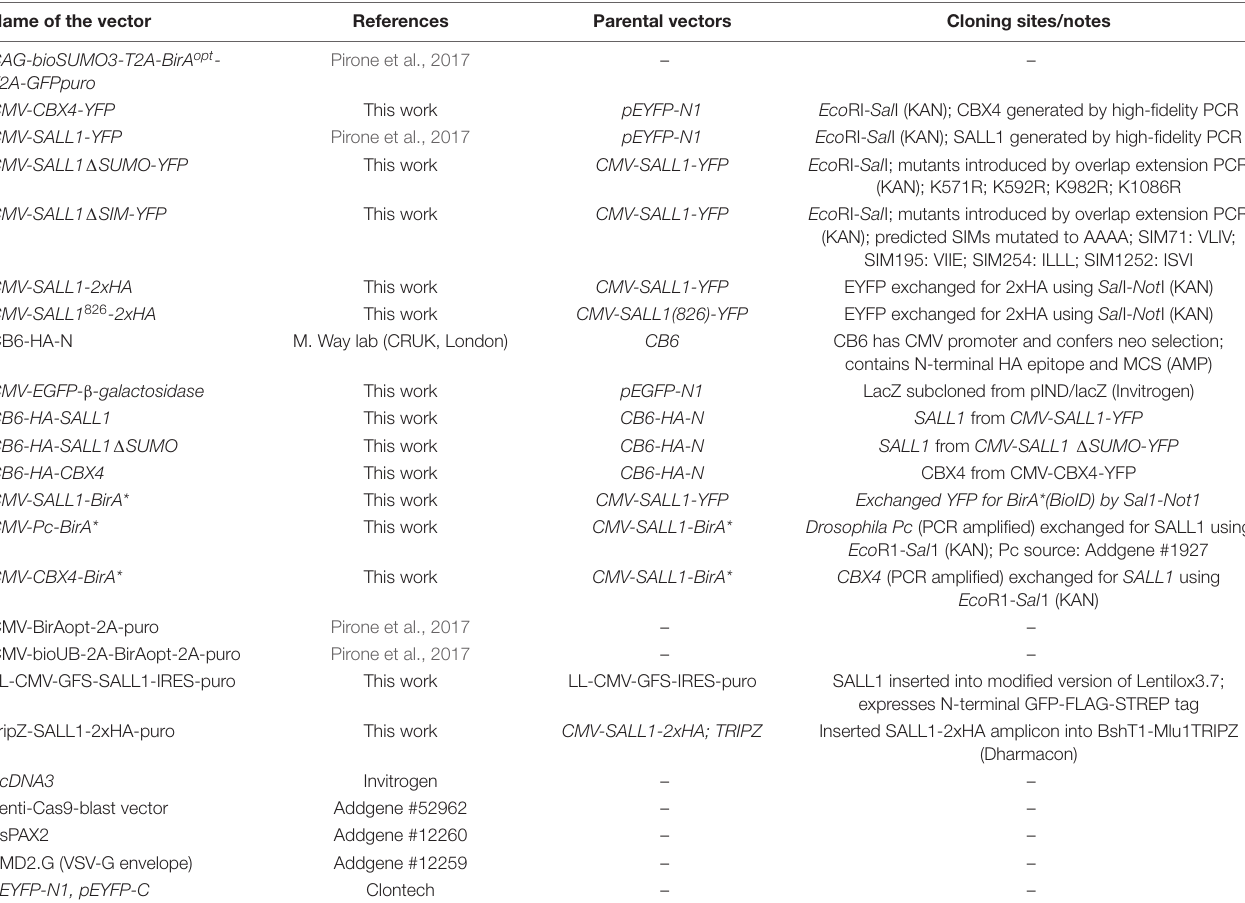
TABLE 1 | Plasmids used in the